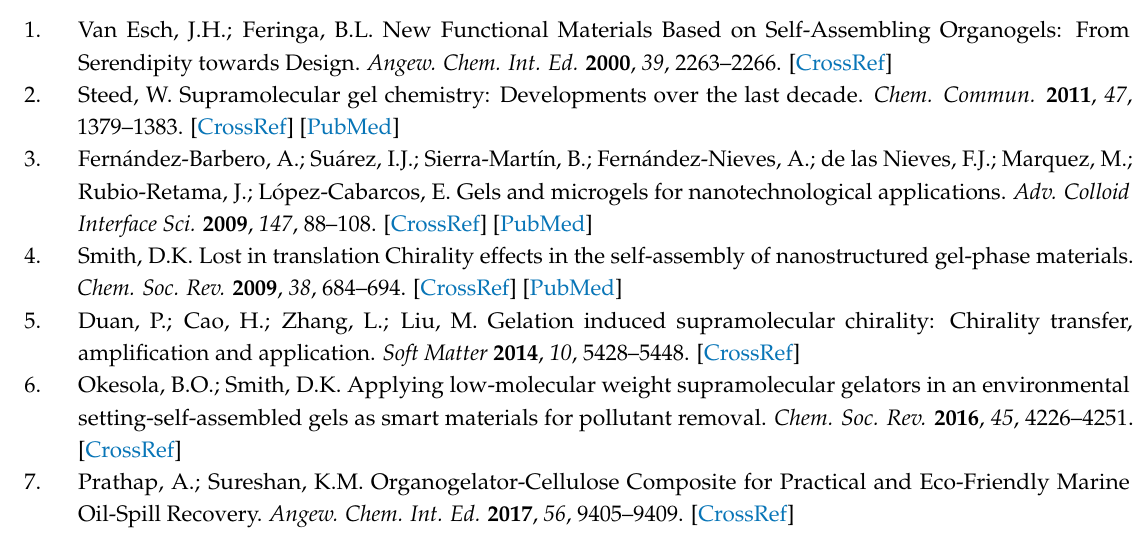
Supplementary Materials: The following are available online: 1 H-NMR and 13 C-NMR spectra for compounds 7 , 8 , 3 , cis - 2 , 5 , 10 , 11 , trans - 2 and 4 ; Figure S1. Predicted CD spectra of compounds cis - and trans -2; Figure S2. Calculated aggregation energies per monomer of compounds 2 – 5 ; Figure S3. Predicted structures for aggregates 4- α and 4- β ; Total energies of aggregates of compounds 2 – 5 ; Cartesian coordinates of aggregates of compounds 2 – 5